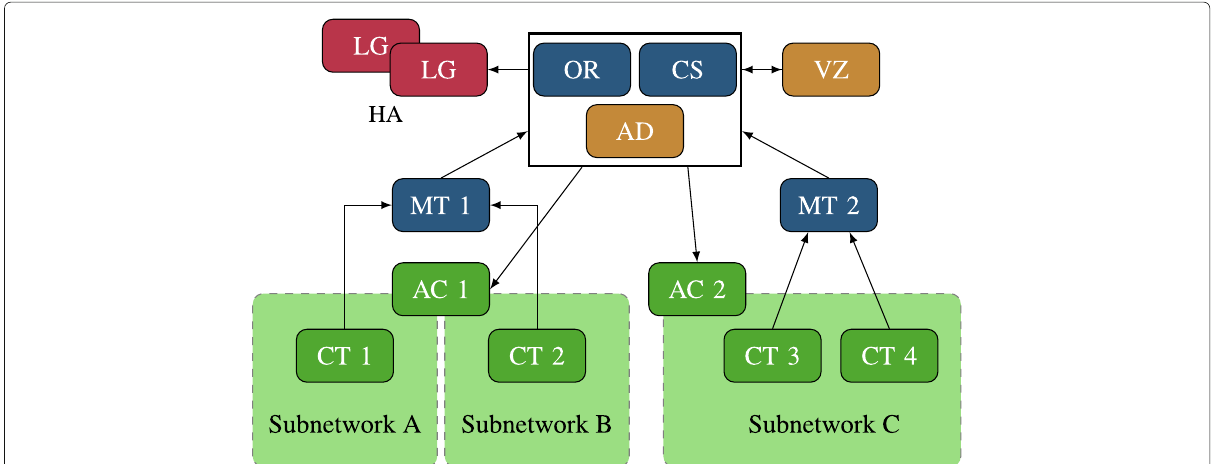
Fig. 5 Example of an implementation of OMMA where we can see its